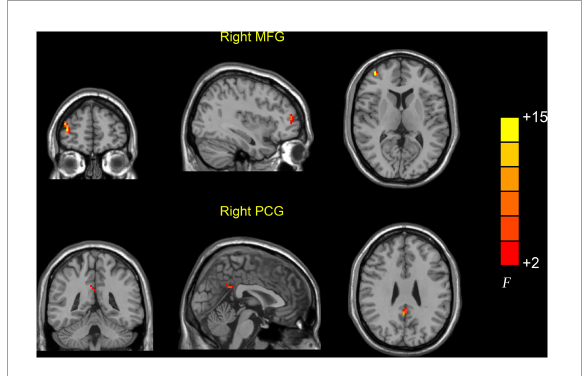
FIGURE1 Brain regions showing abnormal dReHo values among the AD, MCI, and HC groups. Differences in dReHo were shown in the right MFG and PCG among the three groups using ANOVA. HC, healthy control; MCI, mild cognitive impairment; AD,